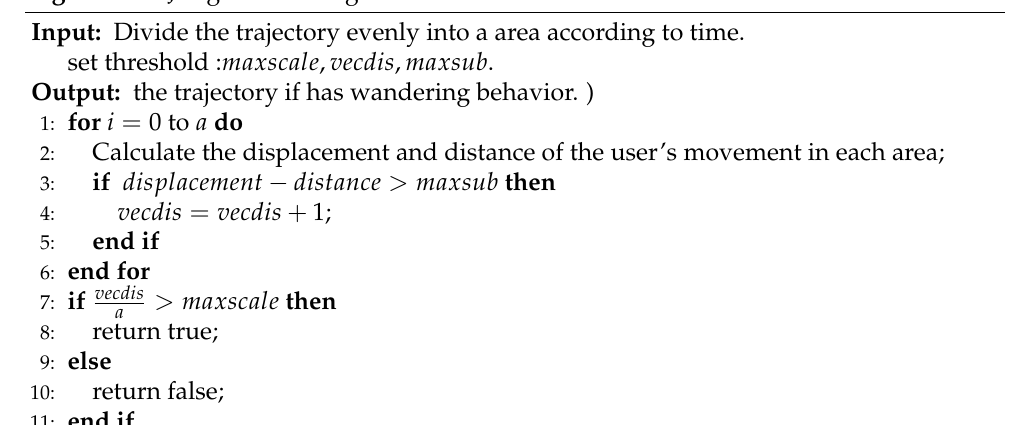
Algorithm 3 Judge wandering